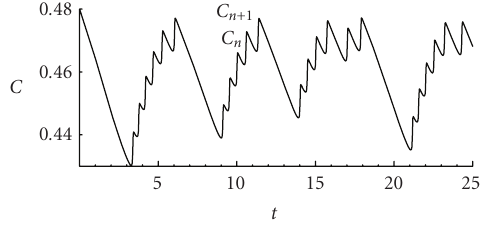
Figure 2.7. Time sequence of calcium concentrations for g K , C = 11 . 0 s − 1 .